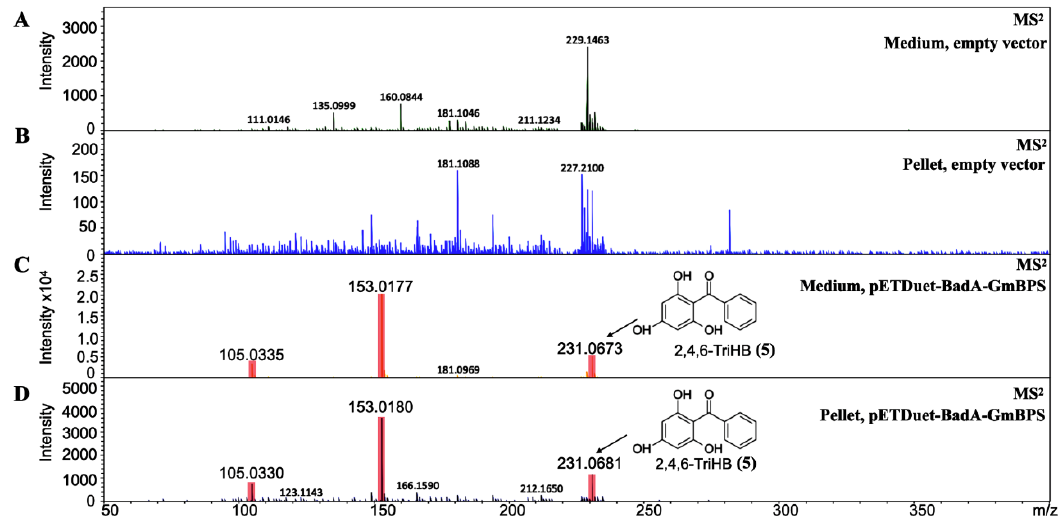
Figure 4. The identification of 2,4,6-TriHB ( 5 ) from the culture medium and pellets by using high-resolution LC-ESI (+)-QTOF-MS/MS (CID of 20 eV). ( A ) No MS/MS spectra of 2,4,6-TriHB ( 5 ) were detected from the medium extract of clones harboring pETDuet-1 empty vector (control). ( B ) No MS/MS spectra of 2,4,6-TriHB ( 5 ) was found in the pellet extract of clones harboring pETDuet-1 empty vector. ( C ) The MS/MS spectra of 2,4,6-TriHB ( 5 ) (red highlights) from the medium of clones harboring pETDuet-BadA-GmBPS. ( D ) The MS/MS spectra of 2,4,6-TriHB ( 5 ) (red highlights) from the pellet of clones carrying pETDuet - BadA - GmBPS .